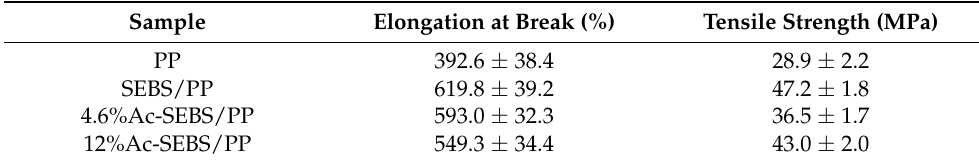
Figure 6. Stress–strain curve of PP and its blends. Table 1. Summary of the tensile test data of the samples.